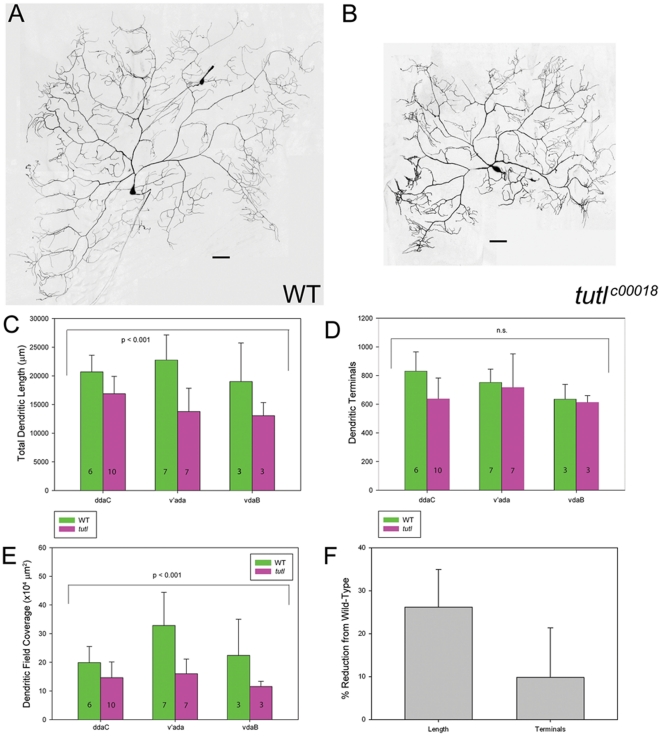

tutl is required for class IV da neuron dendritic growth and dendritic field specification.(A) Wild-type class IV v'ada neuron. (B) tutl mutant class IV v'ada neuron. As compared to wild-type, tutl mutant class IV da neurons display an overall reduction in dendritic length and dendritic field coverage. Images taken at 40X magnification and size bar represents 50 microns. (C) Quantitative analyses of overall dendritic length revealed a significant reduction in tutl mutant class IV da neurons relative to wild-type controls (p<0.001, two way ANOVA). The n value for each class IV da neuron subtype for both wild-type and tutl mutants is indicated on the bar graph. (D) Quantitative analyses of the total number of dendritic terminals revealed no significant (n.s.) reduction in tutl mutant class IV da neurons relative to wild-type controls (p>0.05, two way ANOVA). The n value for each class IV da neuron subtype for both wild-type and tutl mutants is indicated on the bar graph. (E) Quantitative analyses of total dendritic arbor demonstrate area is significantly reduced in tutl mutant class IV da neurons relative to wild-type controls (two way ANOVA, p<0.001). The n value for each class IV da neuron subtype is indicated on the bar graph. (F) Quantitative analyses revealed that in tutl mutants dendritic length is reduced by an average of 26% whereas terminals are reduced by approximately 10%. For these analyses each of the three class IV da neuron subtypes (ddaC, v'ada, and vdaB) in both wild-type and tutl mutants were compared. The average percent reduction from wild-type in tutl mutants of each of the three subtypes is reported.